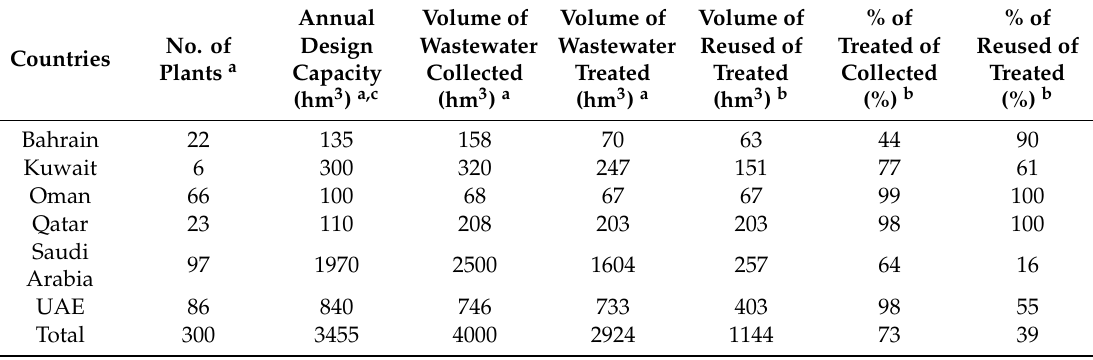
Table 3. Wastewater collection, treatment, and reuse capacity in the GCC